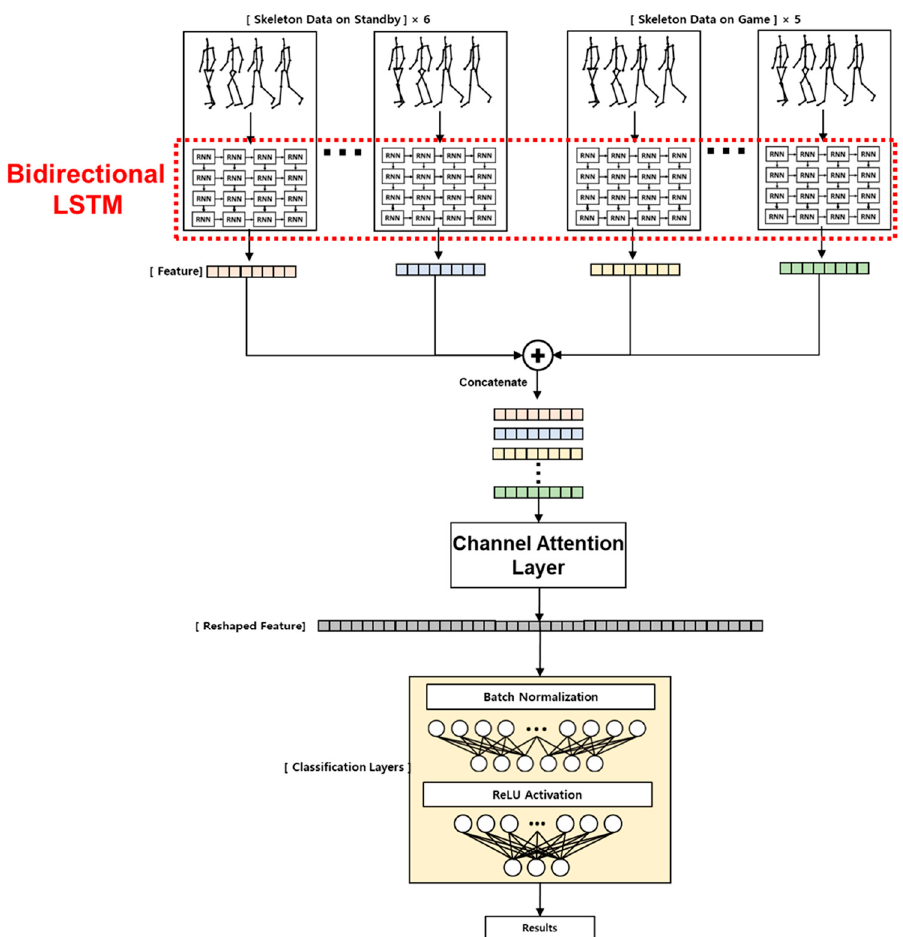
Figure 5. Deep learning model with an added attention layer based on bidirectional long short-term memory (LSTM) used for ADHD screening of children.